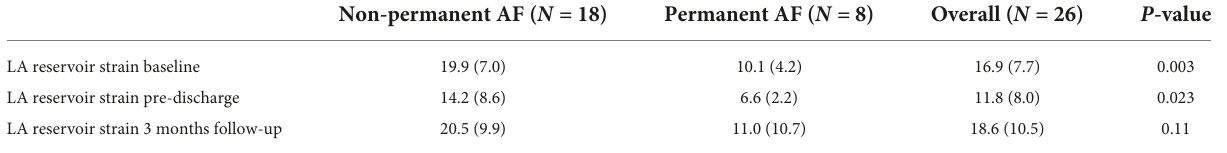
TABLE 3 2D strain results for permanent vs. non-permanent atrial fibrillation